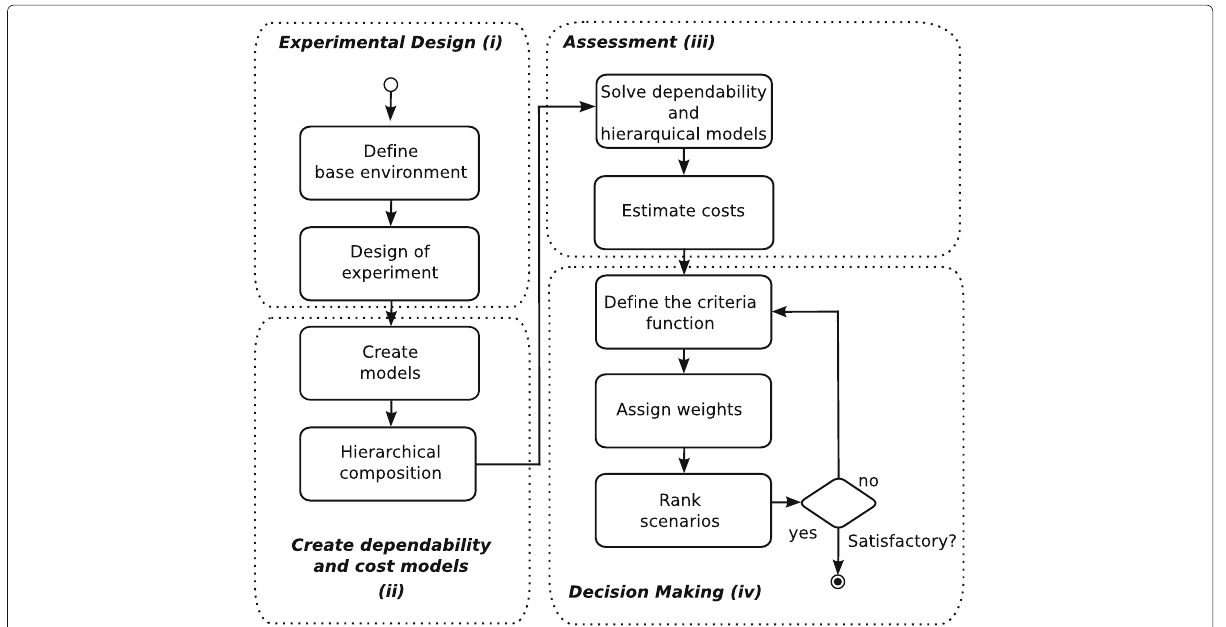
Fig. 1 Strategy for decision making in cloud computing